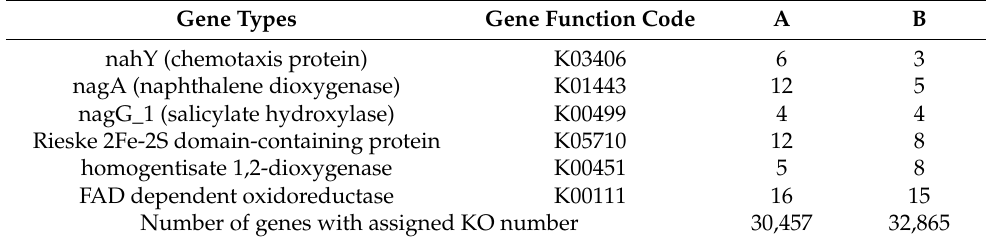
Table 6. Normalized gene counts of major PAH catabolic genes in samples. Gene